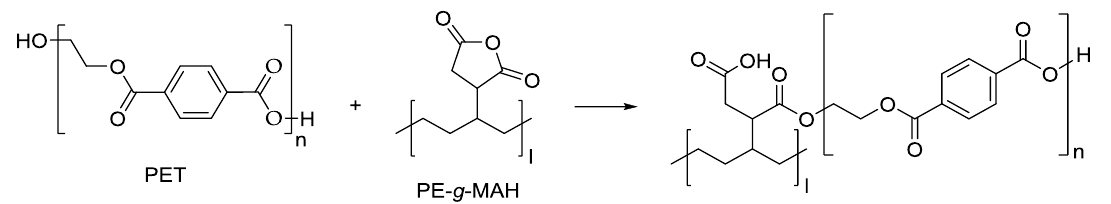
Figure 5. Chemical reaction between the terminal hydroxyl groups of PET with maleic anhydride groups of PE- g -MA [95].